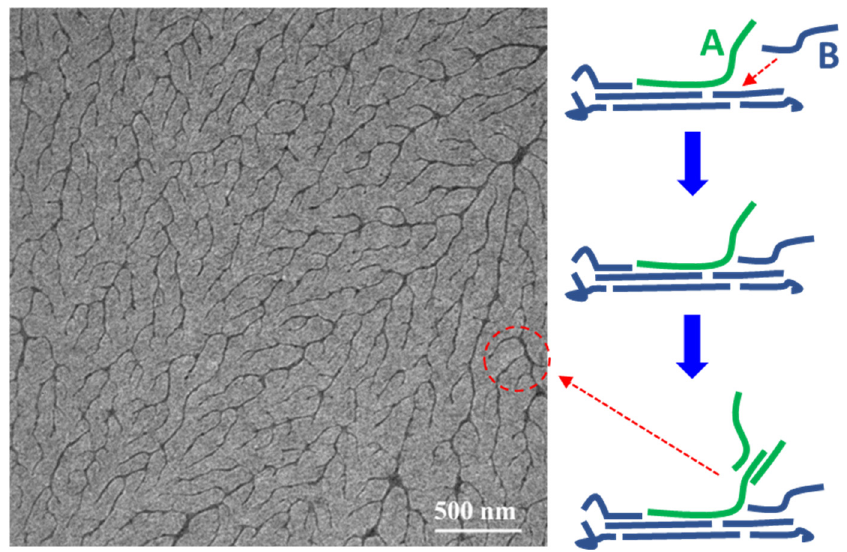
Figure 13. Schematic diagram of the formation process of rhizoid crystals, which was adapted from reference [117] with permission from Copyright 2022 Elsevier Ltd.